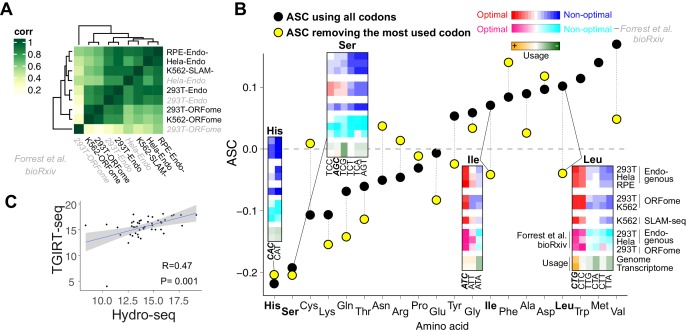
Few amino acids can potentially be related with mRNA stability in human lines.(A) Heatmap showing the Spearman rank correlations between CSC calculated in different human cells lines and using different methods to calculate mRNA stability (Figure 1C) and scores from Forrest et al, preprint (bioRxiv_ (labeled in gray). For bioRxiv data (Forrest et al., 2018), the codon were ranked based on their optimality. (B) Scatter plot for ASC as the Person correlation coefficient between mRNA stability and amino acid occurrence (Bazzini et al., 2016) from 293T endogenous mRNA decay. The black dots indicate the ASC score considering all synonymous codons for a given amino acid, the yellow dots reflect the ASC score without taking in consideration the most abundant codon for each amino acid. Heatmap inside showing the CSC score from all our data and the CSC score rank from Forrest et al. (2018). The codon usages (genome and transcriptome) are also shown. (C) Scatter plot sowing the tRNA level measured with Hydro-seq and TGIRT-seq in 293T cells. The axis is log10 tRNA read counts. Spearman correlation was used, p value and R value indicated.